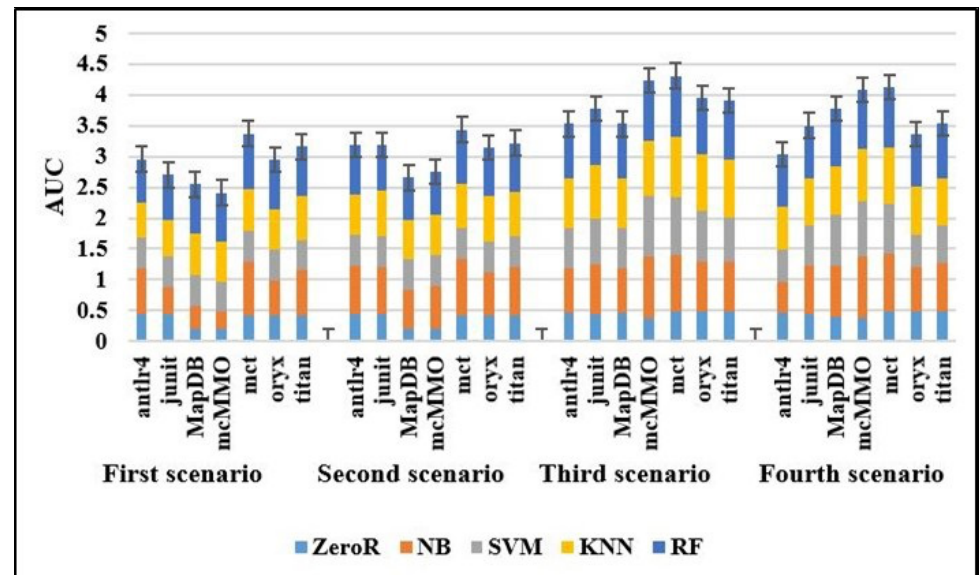
Figure 4. Ranking of the AUC for prediction models on all scenarios.